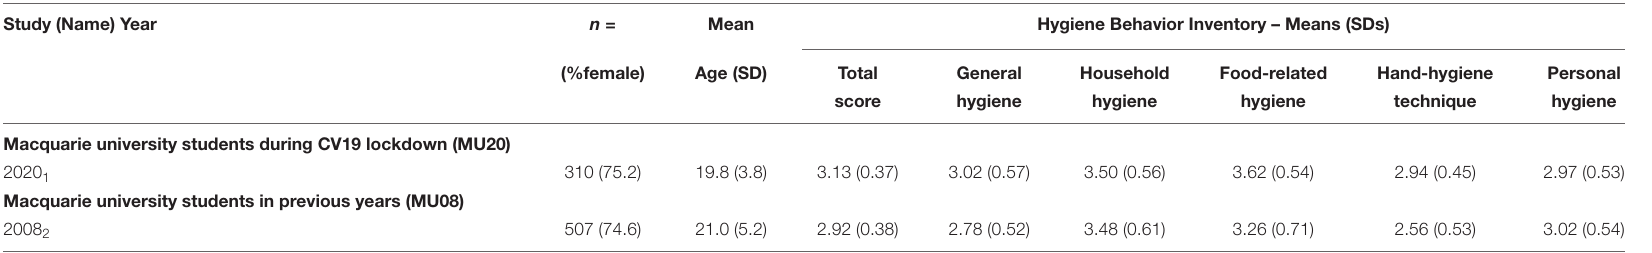
TABLE 8 | Sample details for the analyses of the Hygiene Behavior